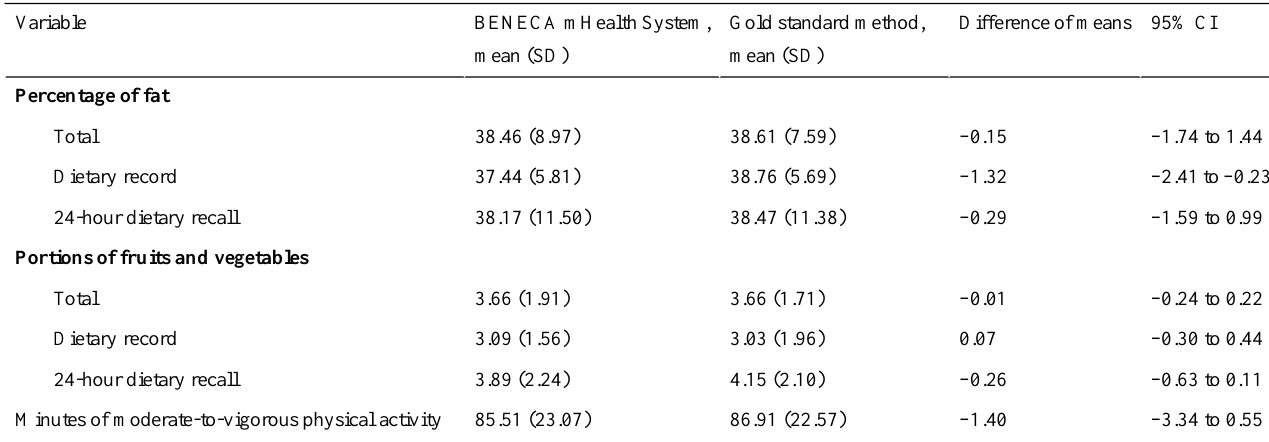
95% CIDifference of meansGold standard